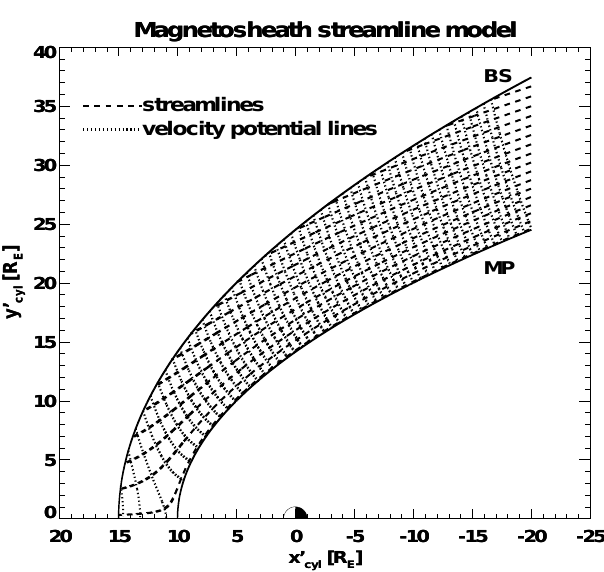
Fig. 6. Streamlines and velocity potential lines of the analytical streamline model in Earth’s magnetosheath bounded by the bow shock (BS) and magnetopause (MP) models.